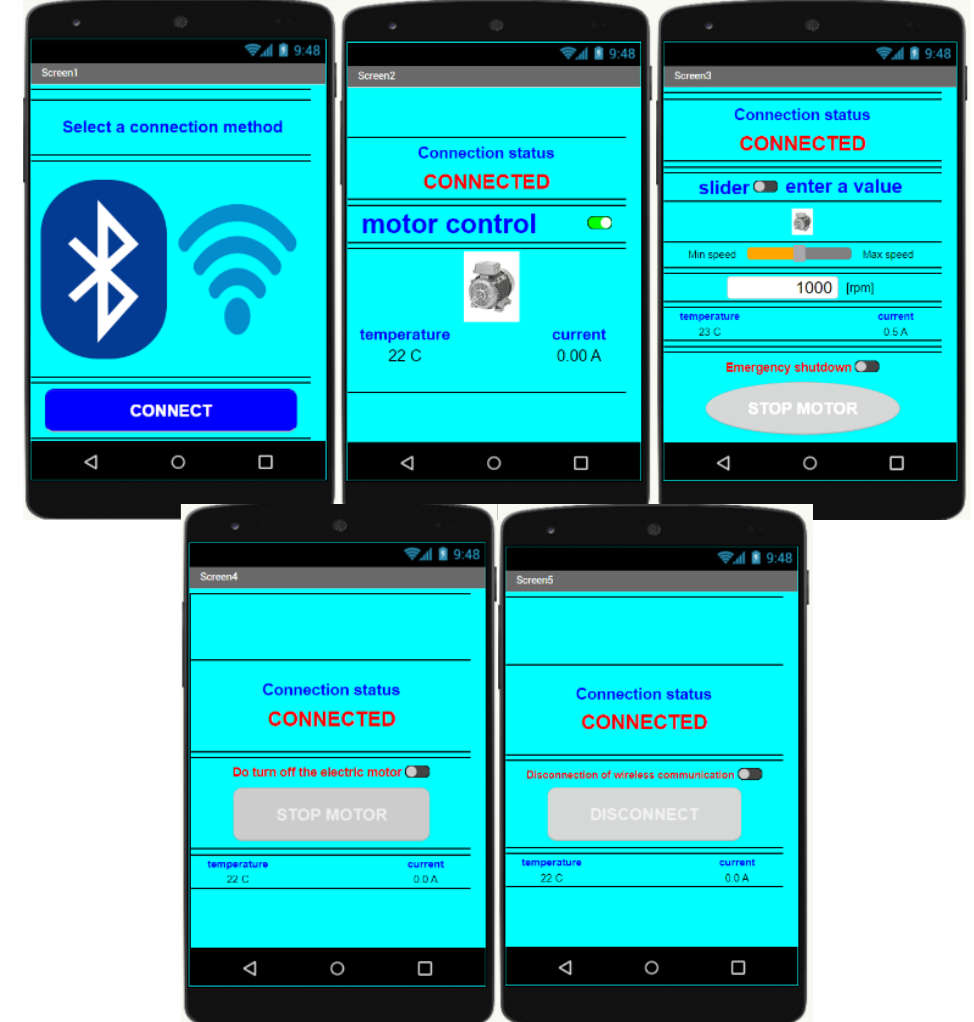
Figure 4. The interface of the developed mobile application with sequentially switched screens; from the left: screen 1, establishing a connection (Bluetooth or Wi-Fi); screen 2, enabling control; screen 3, motor rotational speed control (using a slider or entered value) with an emergency stop; screen 4, motor shutdown; screen 5, disconnection.